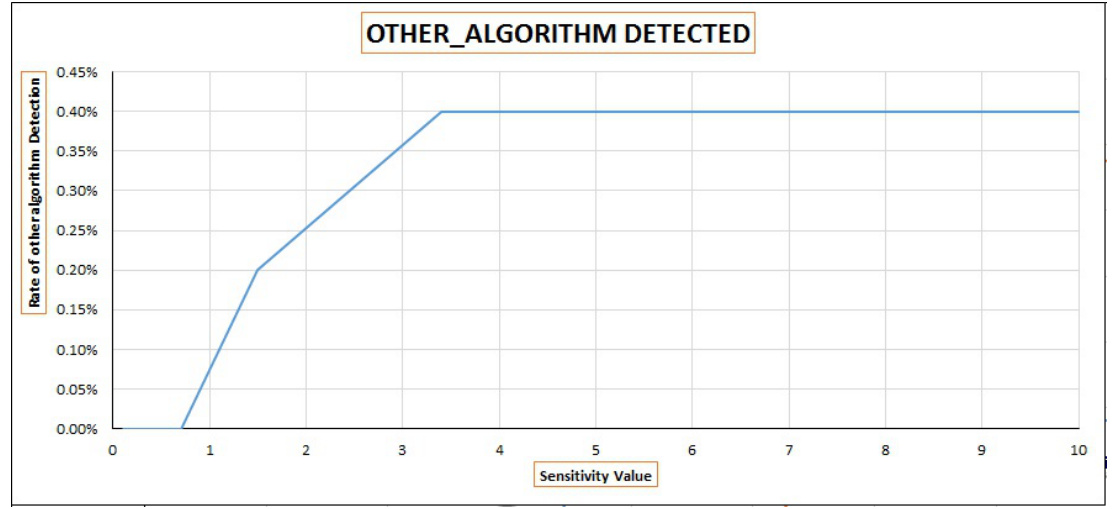
Figure 5. Changes in the jphide rate with different sensitivities for seam carve untouched images.